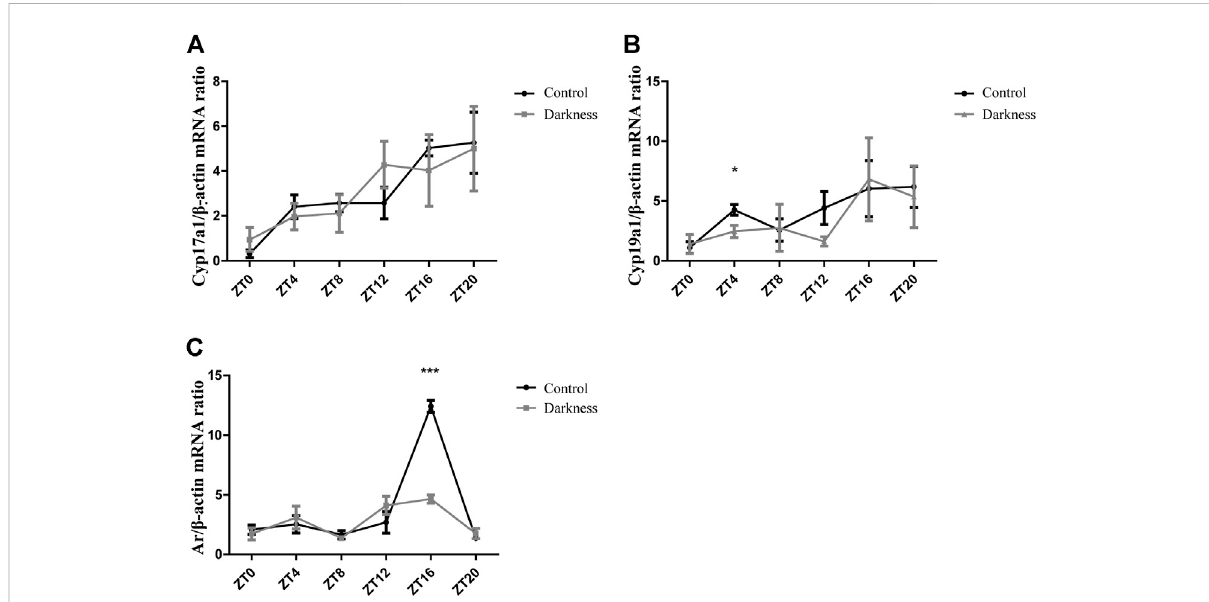
FIGURE 3 Gene expression patterns of Cyp17a1 , Cyp19a1 , and Ar in rat ovaries. (A) Relative mRNA abundance of Cyp17a1 in rat ovaries. (B) Relative mRNA abundanceof Cyp19a1 inratovaries. (C) RelativemRNAabundanceof Ar inratovaries. N =5/group.Valuesareexpressedasmeans±SEM.Signi fi cant differences between the two groups are indicated by asterisks (* p < 0.05, ** p < 0.01, and *** p <